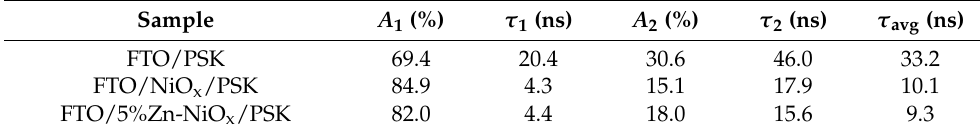
Table 2. PL lifetime parameters from the fitting curves of NiO x and 5% Zn-NiO x thin films.